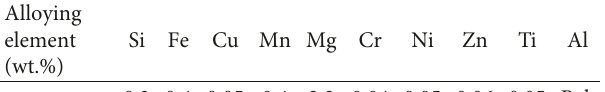
Table 1: Chemical composition in wt.% of 5754-H111 aluminum alloy.